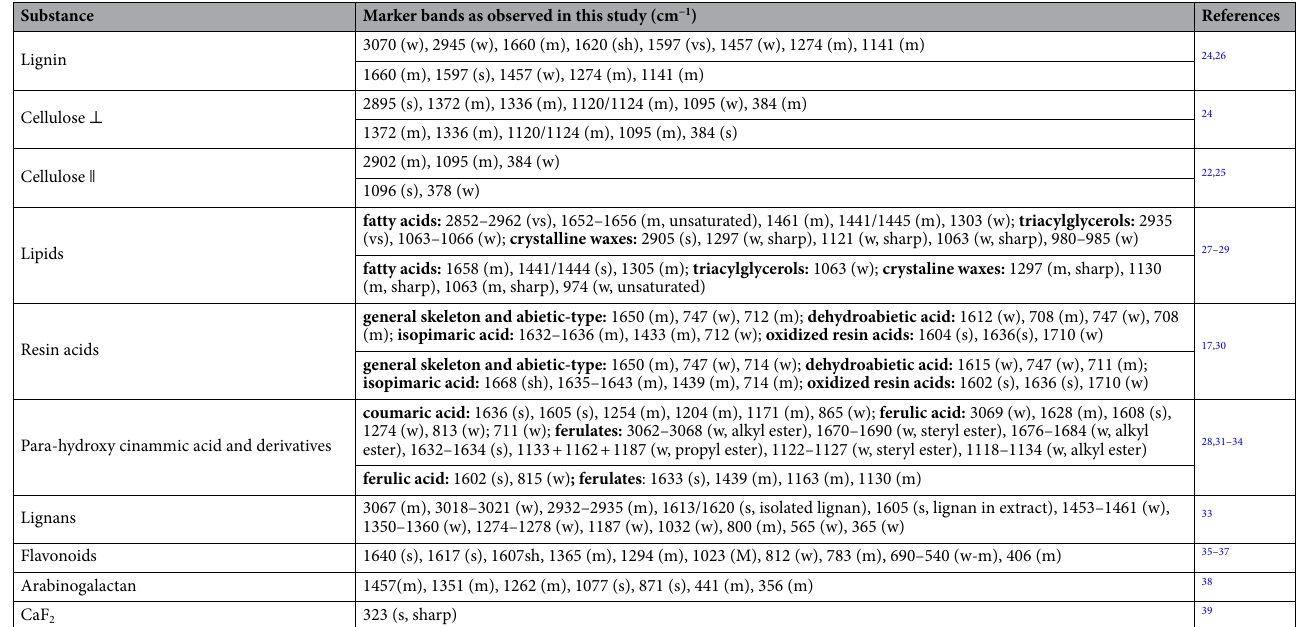
Table 1. Raman marker bands of the cell wall polymers present in wood, as well as of several substances found in extracts and MCR-ALS components of Norway spruce and Kurile larch. Cellulose orientation as indicated in the table is relative to the incident beam polarization. Rows with a grey background show the bands found in Kurile larch using an excitation wavelength of 785 nm. Rows in white show bands found in Norway spruce at excitation wavelength 532 nm. The intensities have been assigned in approximate relation to the highest peak in the respective